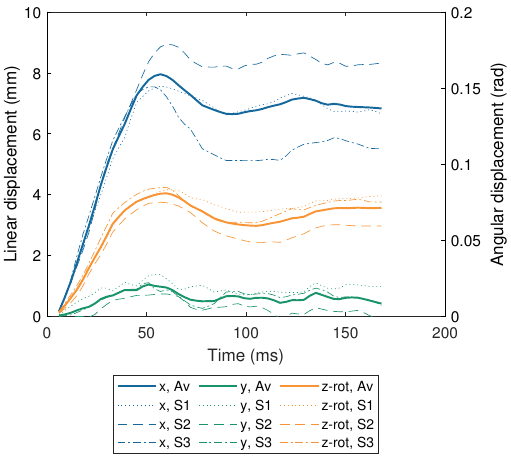
Figure 6. Rigid body (skull) displacements in the anterior-posterior ( x ), inferior-superior direction ( y ) and about the medial-lateral axis ( z -rot) recorded by Feng et al. [54] during mild frontal impacts to three subjects (S1, S2, S3). The authors have calculated and also present the average motion across the three subjects, resulting in mean peak displacements of 8.0 mm ( x ), 1.0 mm ( y ) and 0.1 rad ( z